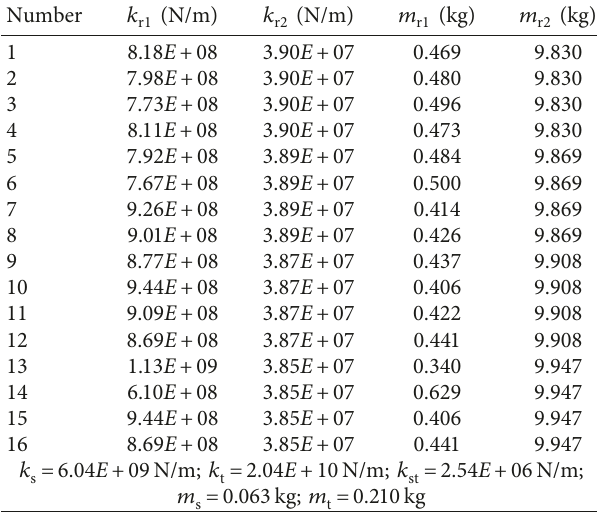
Table 5: Computed stiffnesses and masses for the FSSB and an- chorage nut based on the field test results.